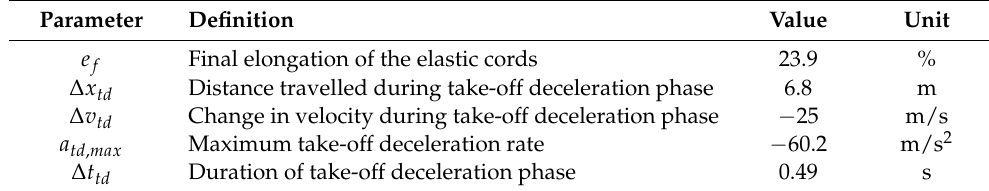
Table 11. The dynamics of the carriage during the take-off deceleration phase.